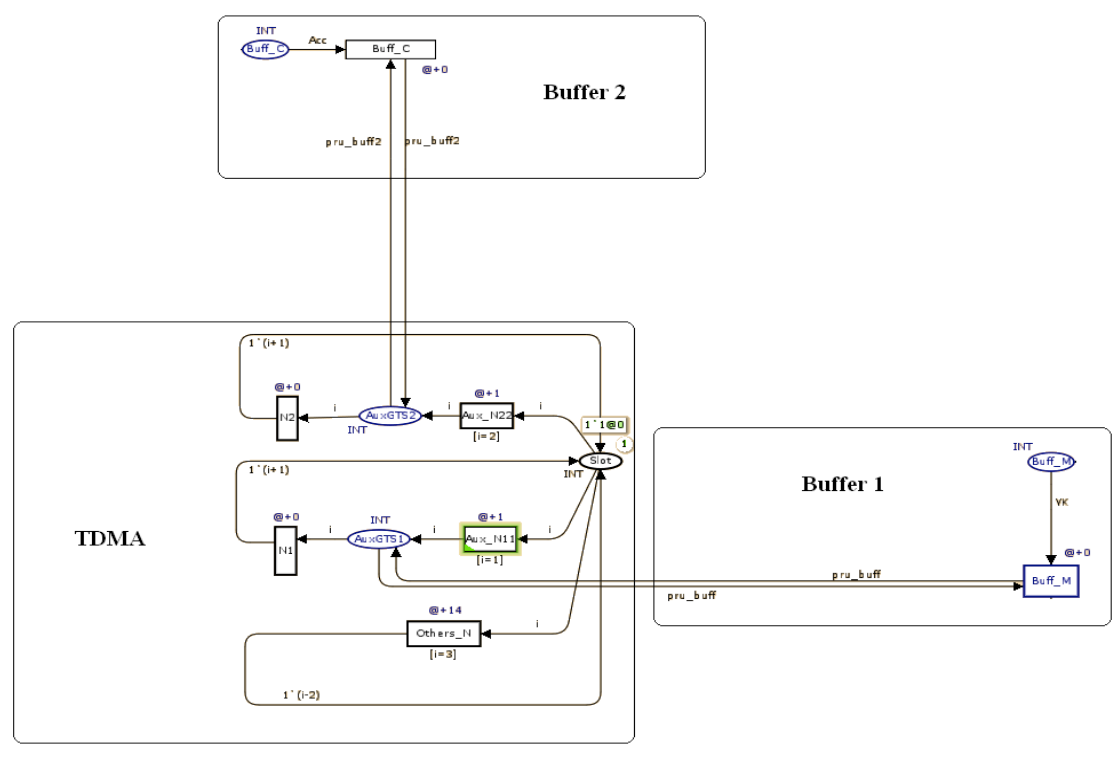
Figure 6. Representation in CPN of a TDMA network with two